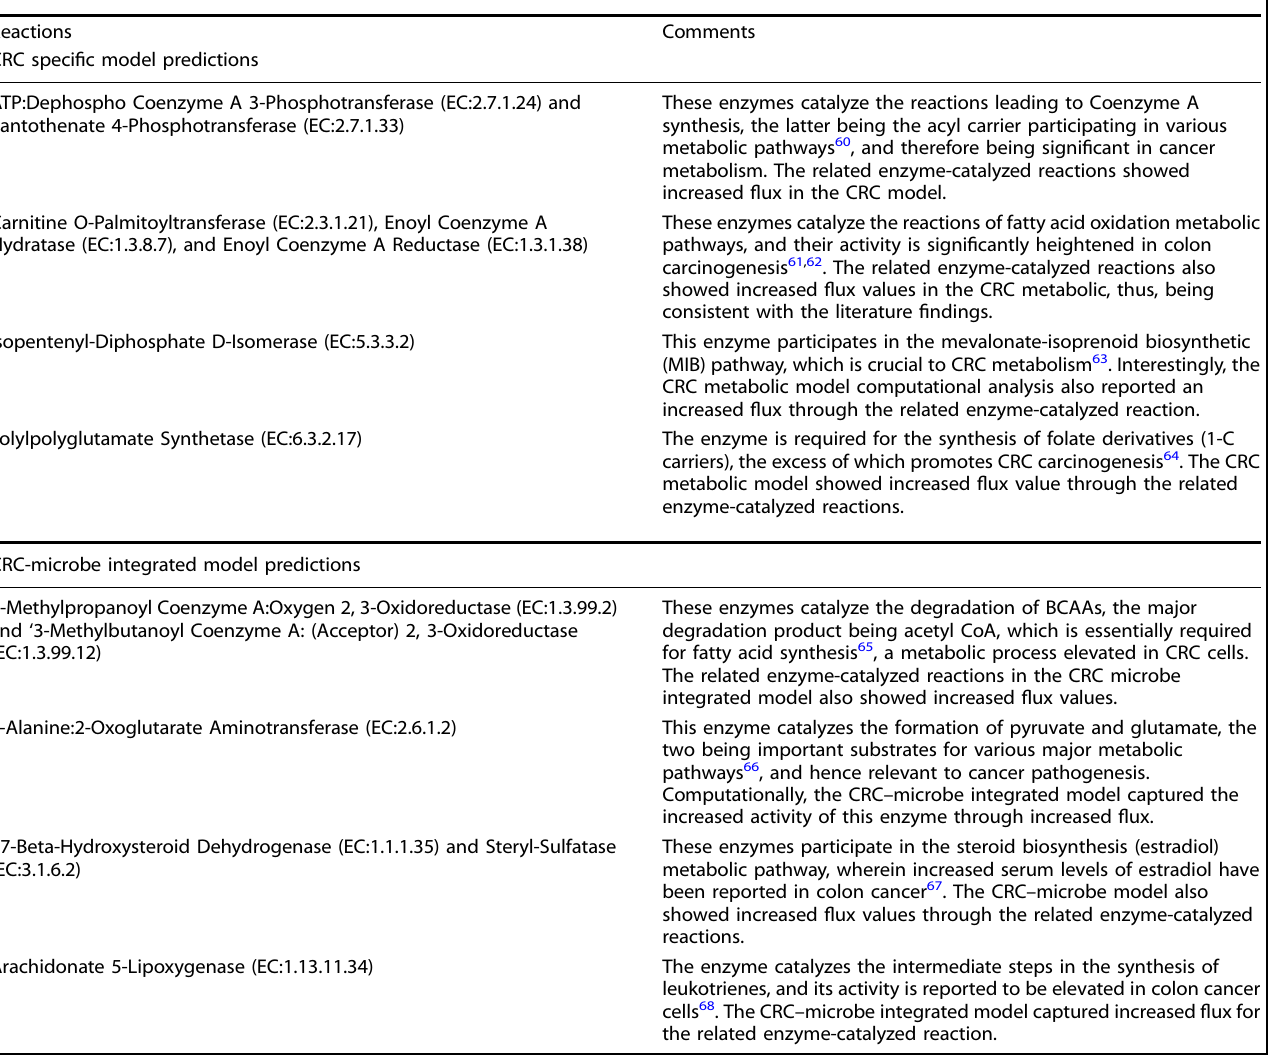
Table 1. Host and host-microbe model predictions in agreement with